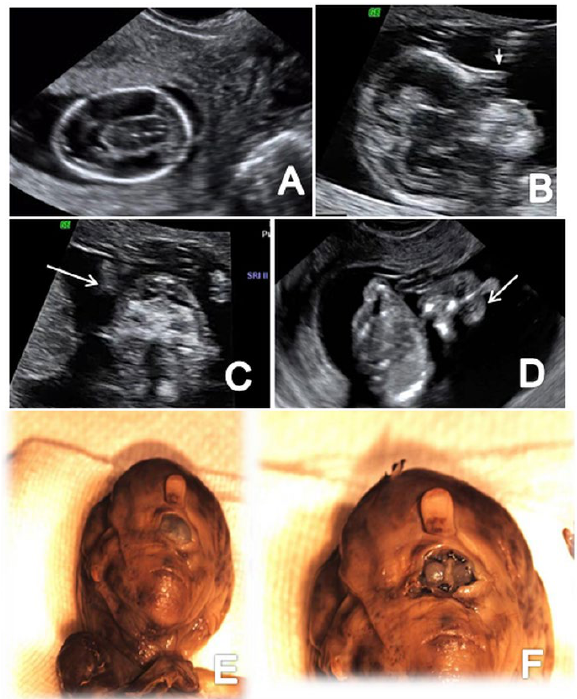
Figure 7. A case of alobar holoprosencephaly diagnosed at 12 weeks + 5 days (Case 9): ( A ) transverse view of the abnormal brain cavities; ( B ) sagittal view of the fetal head showing proboscis (arrow); ( C ) frontal view of the fetal face showing extreme hypotelorism (arrow); ( D ) frontal view of proboscis (arrow); ( E , F ) specimen presentation aspect after medical TOP confirming proboscis and hypertelorism.